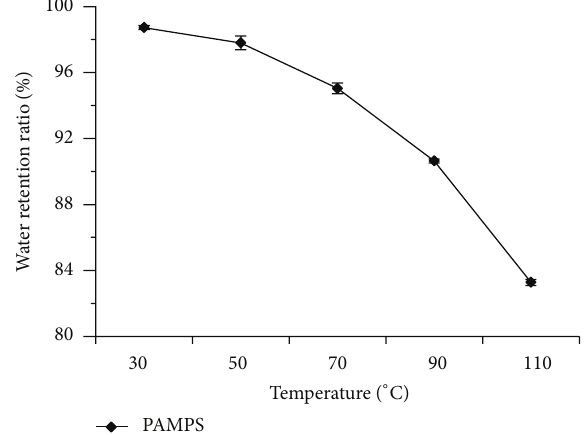
Figure 5: Water retention ratios of F8 PAMPS polymer at different temperature for 30 min. Error bars represent ± S.E. For additional explanations, see Figure 3.